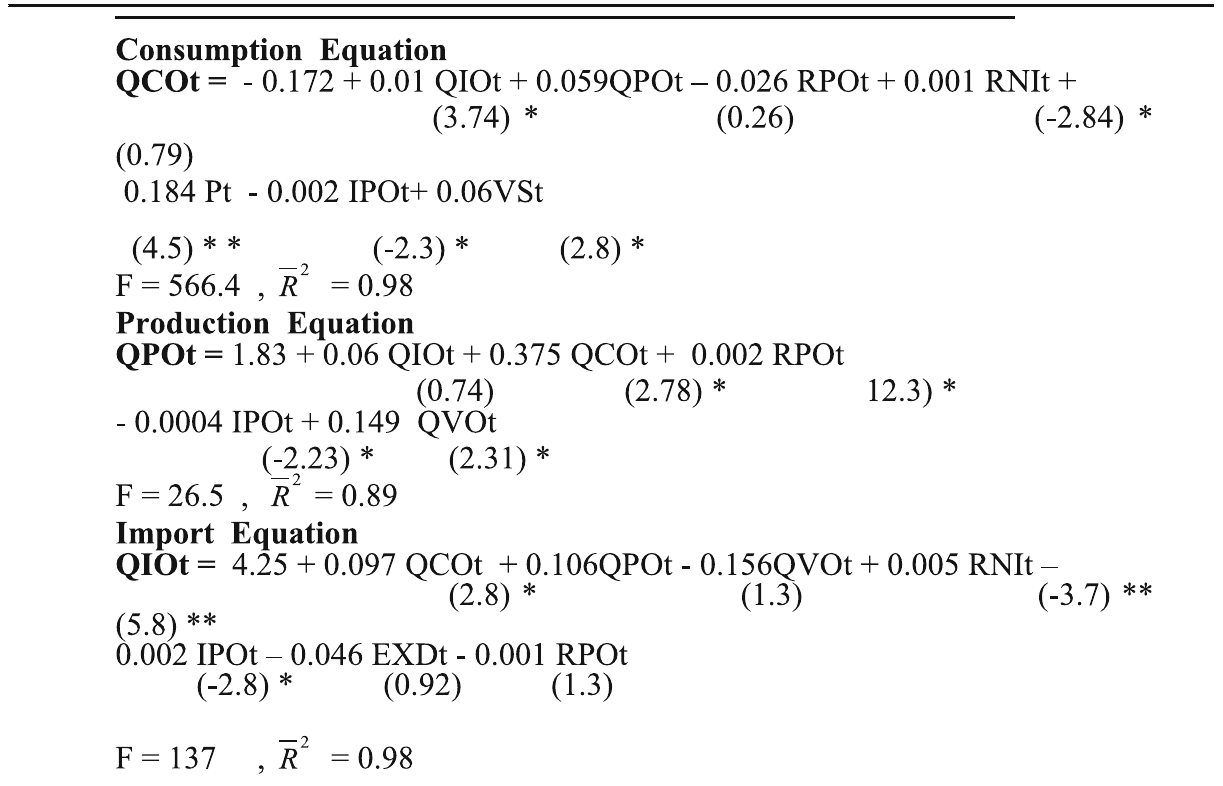
Table 4 Reduced-form estimates for the standard model. Source: calculated from Table